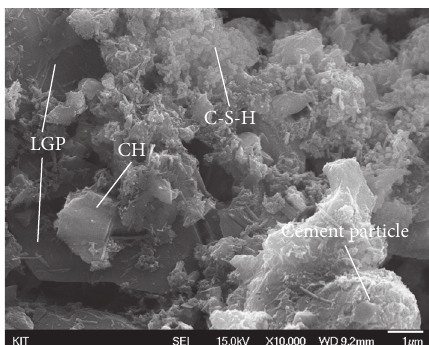
Figure 10: SEM image of composition paste which contained LGP12 10% (3